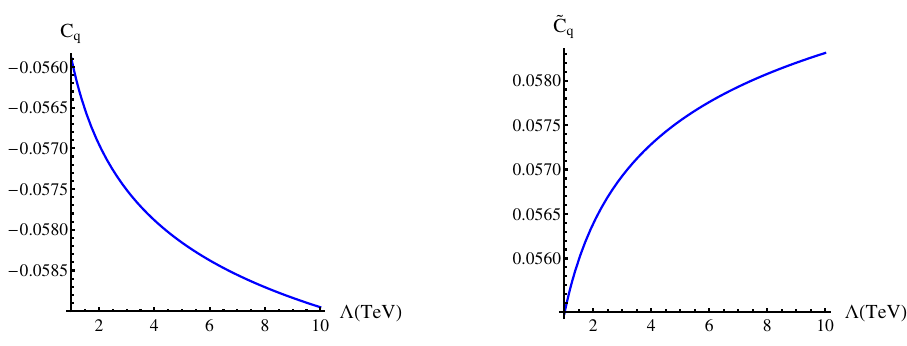
Figure 2 . The induced Wilson coe(cid:14)cients C g (left) and ~ C g (right) for the operators O g and ~ O g of eq. (3.1) at the hadronic scale of (cid:22) = 1 GeV versus the initial scale (cid:3), by numerically solving the set of equations in eq. (3.4){eq. (3.7), with the initial conditions C g = 1 ; C q = 0 (left) or ~ C g = 1 ; ~ C q = 0 (right) at the scale